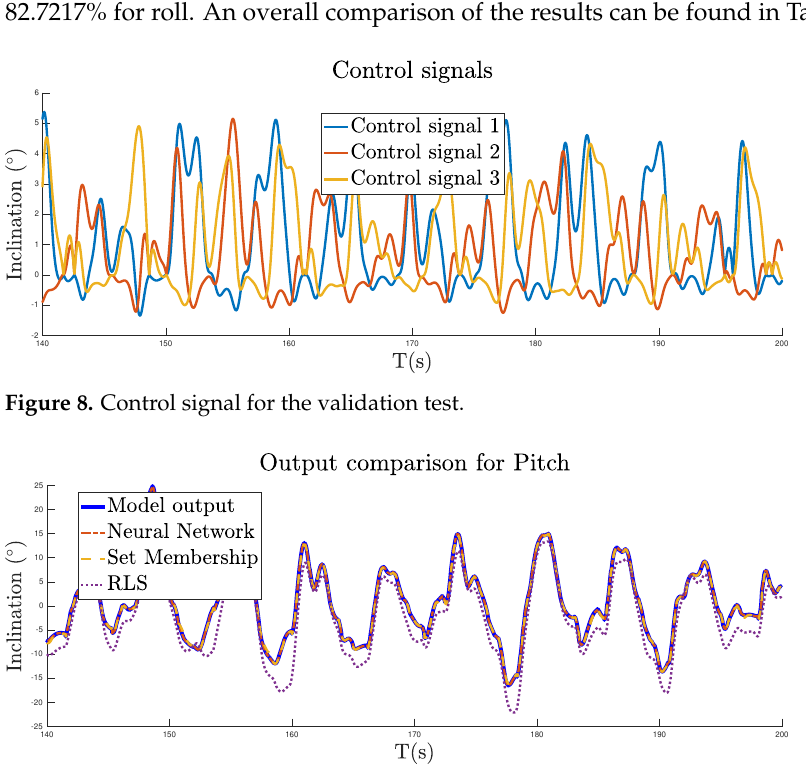
Figure 9. Validation of the pitch